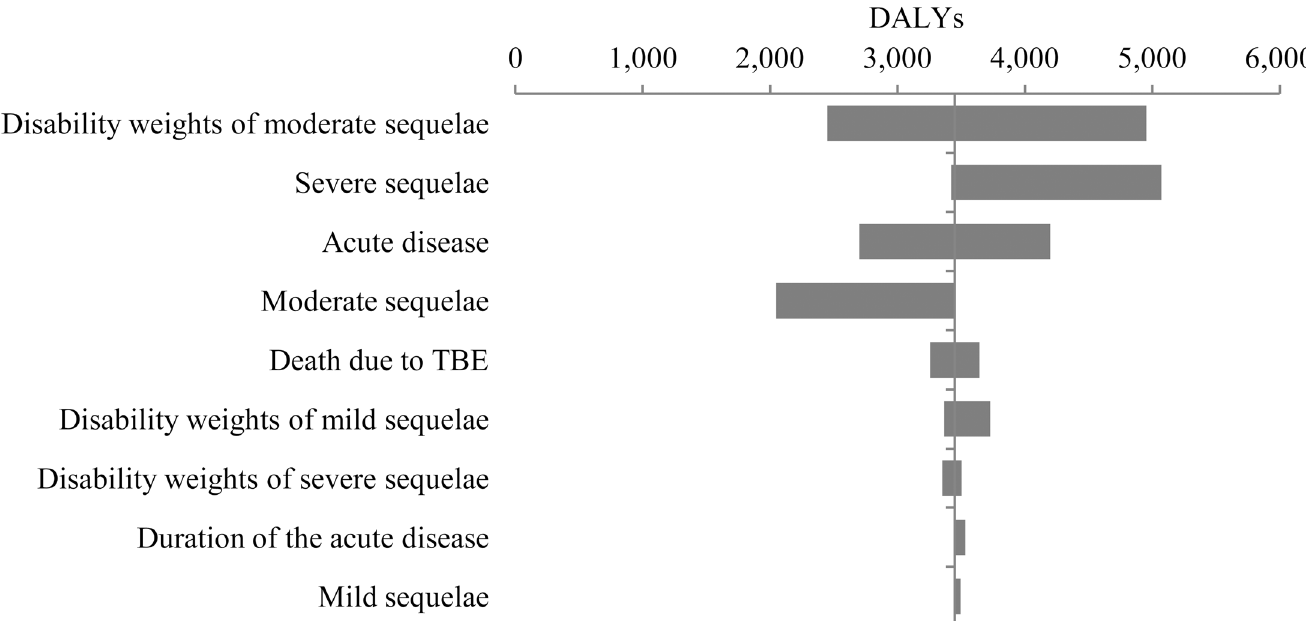
Fig 4. Tornado diagram of the one-way sensitivity analyses of TBE burden expressed in total DALYs from the population